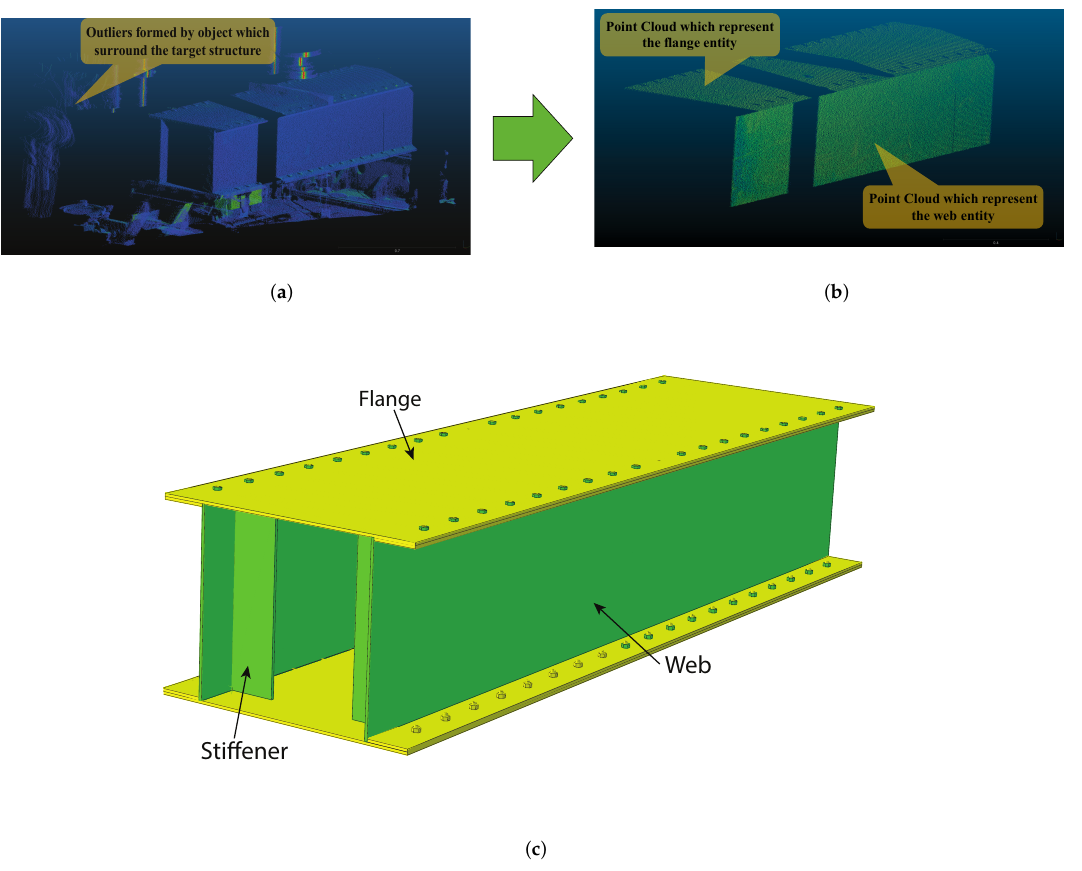
Figure 2. ( a ) Point cloud before preprocessing; ( b ) Point cloud after preprocessing; ( c ) solid figure of a